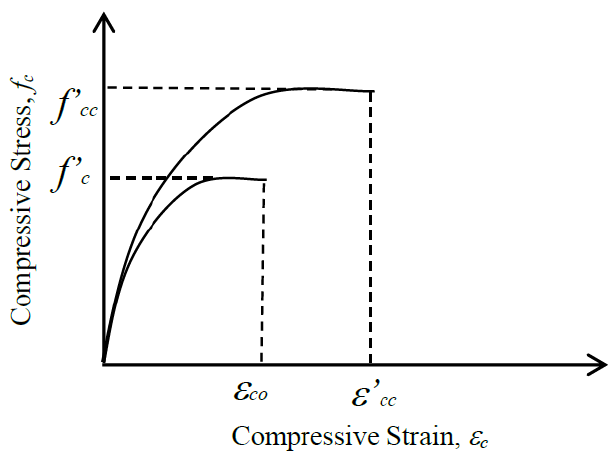
Figure 5. The stress–strain relationships of the concrete cylinders with and without CFRP. Where: f’ cc = the compressive strength of the confined concretes; f’ c = the compressive strength of the unconfined concretes; f’ l = the effective lateral confined stress of CFRP; ϕ = internal friction angle of concretes; n = the number of CFRP wrapping layers; t = the thickness of a single CFRP layer; E cf = the elastic modulus of CFRP; ε cf = the strain of CFRP; k c = a sectional shape factor. In this paper, the internal friction angle was proposed as follows: